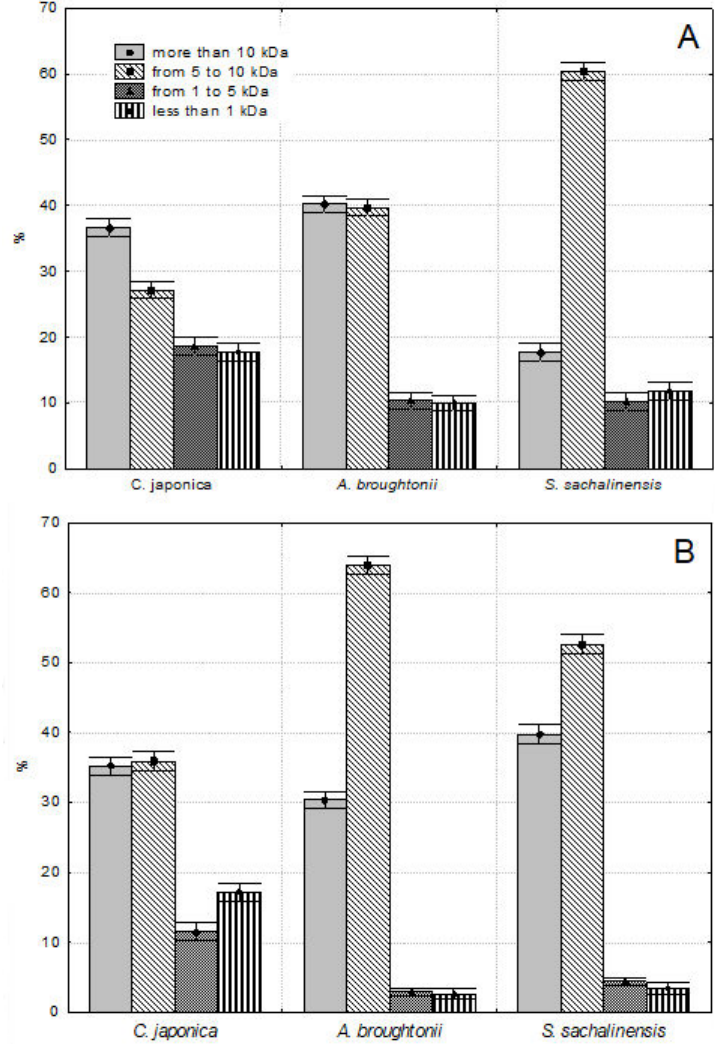
Figure 3. Molecular weight distribution of water-soluble proteins and peptides of cold ( A ) and hot ( B ) water extract of bivalve